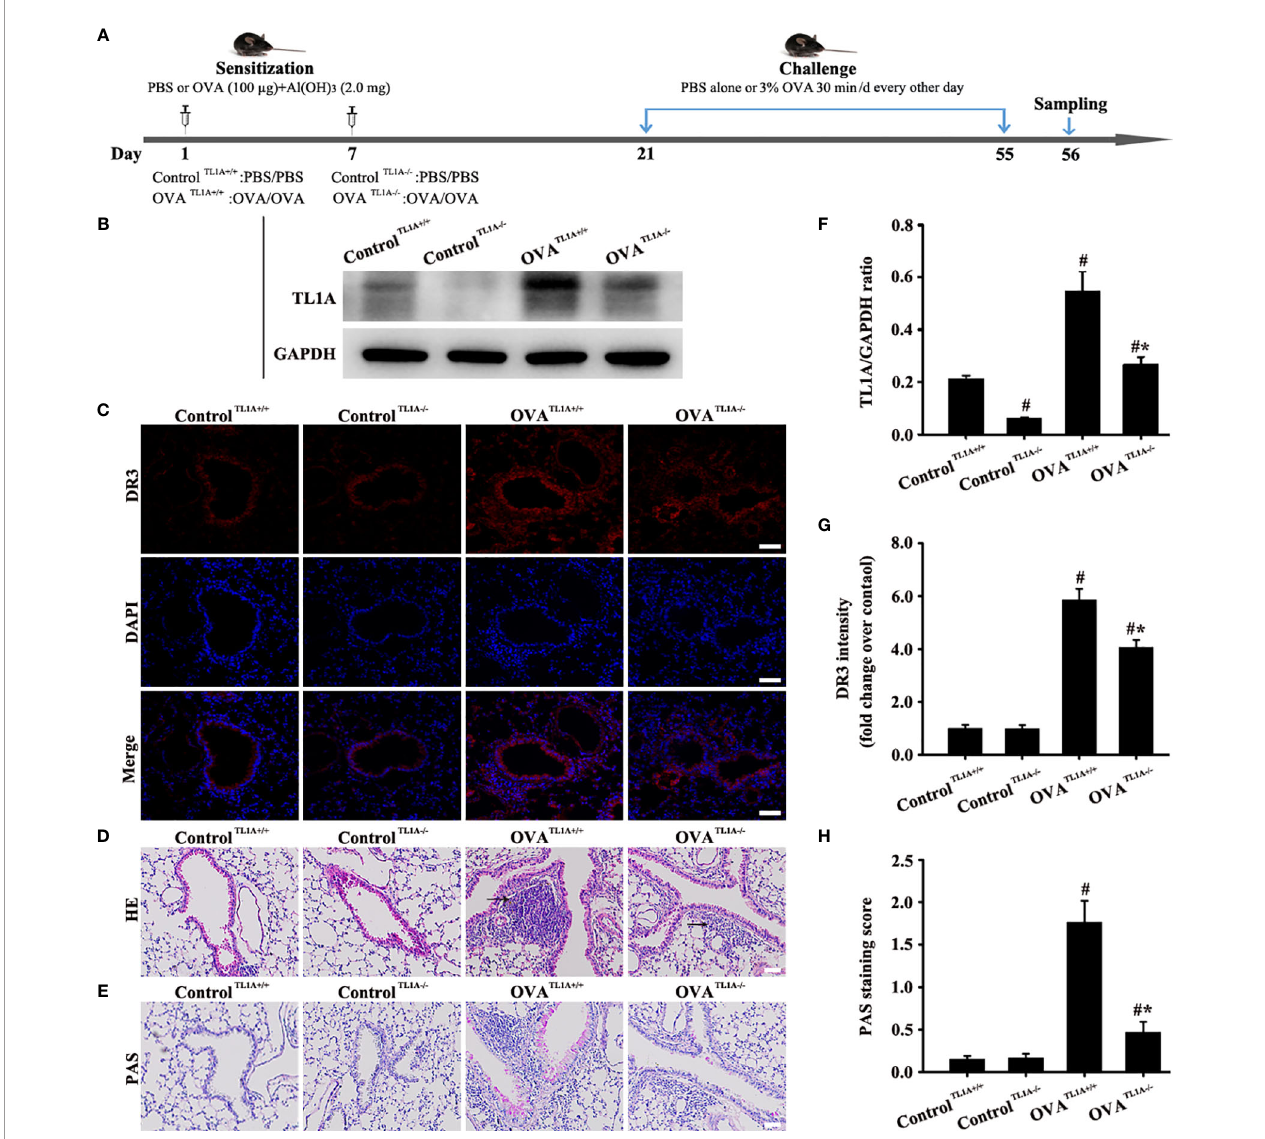
FIGURE 5 | Animal experimental schedule is shown in (A) ( n = 6 in each group). Effects of the knockout TL1A gene on OVA-induced asthma were observed. TL1A levels in the lung as determined by Western blot analysis (B) . Effects of the knockout TL1A gene on DR3 (C) , HE (D) , PAS staining (E) were detected. (C)